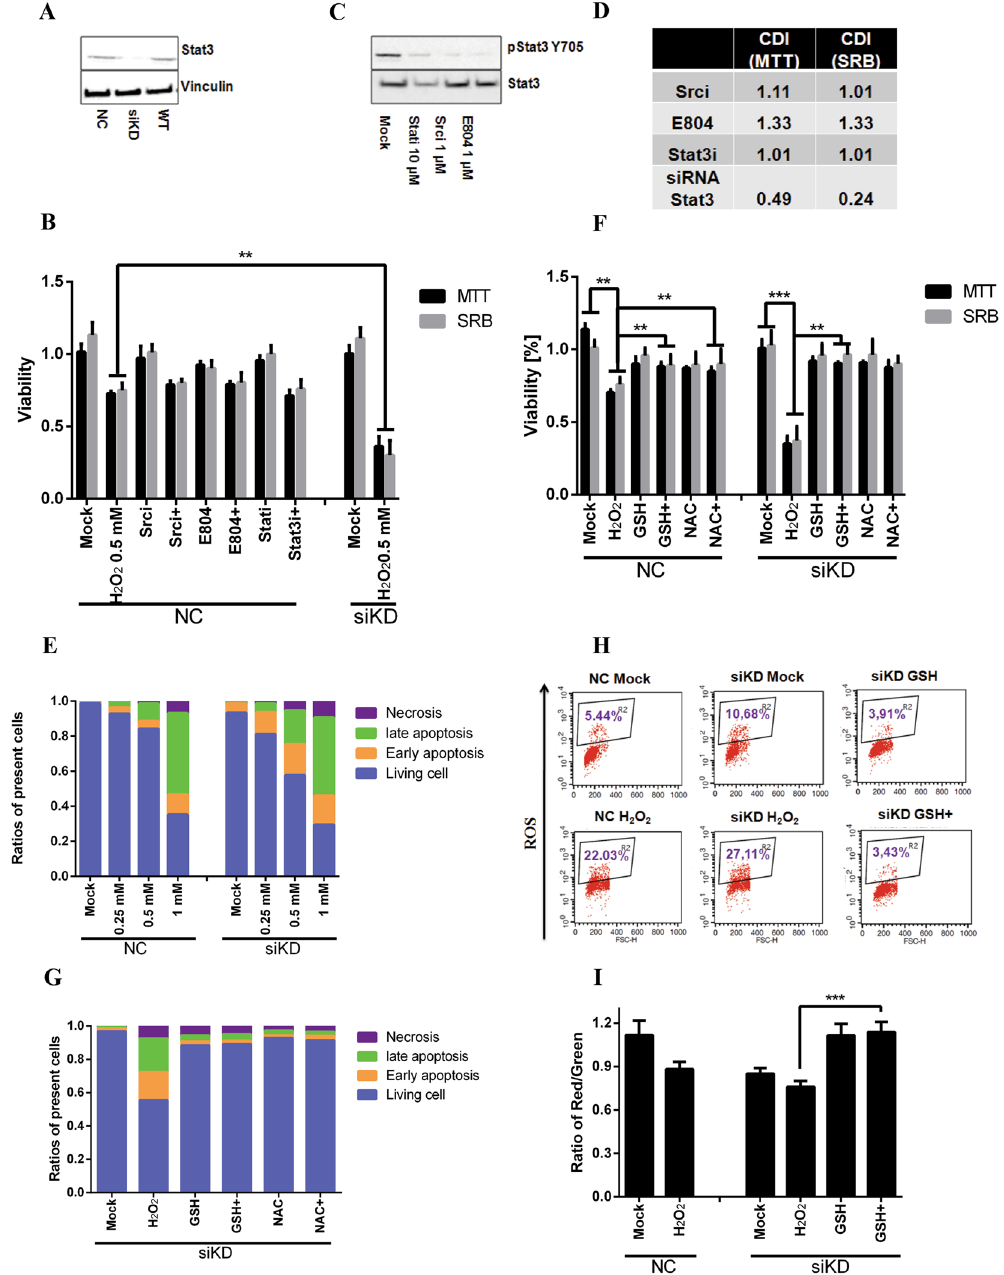
Figure 1. Synergistic toxic effect of H 2 O 2 in combination with Stat3 siRNA. ( A ) The efficiency of siRNA knockdown in HeLa cells was analyzed by immunoblotting. WT: normal HeLa cells; NC: HeLa cells transfected with non-targeting siRNA. siKD: HeLa cells transfected with Stat3 siRNA. ( B ) HeLa NC and siKD cells were treated with H Data were normalized to the value of non-treatment in WT cells showing the mean ± SD of quadruplicates and are representative of three independent experiments. ( C ) Inhibitory effects of Stat3 inhibitors were confirmed by immunoblotting using specific antibody against phospho-Stat3 Y705 in HeLa cells. ( D ) Coefficient of drug interaction (CDI) was calculated for each combination as described in the experimental section. ( E ) NC or siKD cells were treated with increasing concentrations of H 2 O 2 for 24 hrs. Annexin v/PI staining was performed to study cellular apoptosis. Apoptotic cells are annexin v-positive and necrotic cells are PI-positive. Living cells are double negative and late apoptotic cells are double positive. ( F ) Antioxidants prevented cell damage in MTT and SRB assays. NC or siKD cells were incubated with 0.5 mM H 2 O 2 in combination with reduced glutathione (GSH, 5 mM) or N-acetyl-L-cysteine (NAC, 10 mM) for 24 hrs. ( G ) GSH and NAC rescued cell damage induced by H 2 O 2 in apoptosis assay in siKD cells. ( H ) Elevated levels of ROS were detected in siKD cells exposed